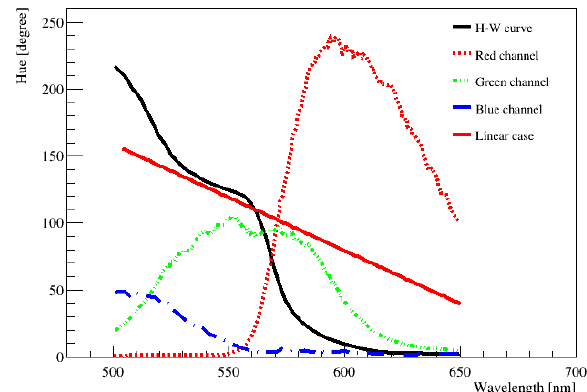
Figure 4. H–W response curve using CMOS CFA technology (for example, Canon 300D camera, manufacturer: Canon, Tokyo, Japan), especially in the green and red wavelength regions adapted from [9,10]. RGB curves are input values to the camera. The plateau regions with a wavelength in the range of 530~560 nm and over 600 nm occur. The red solid line is assumed to be linear [8–11]. To date, the H–W relation has not been well measured below ~500 nm, in particular, the blue color region.